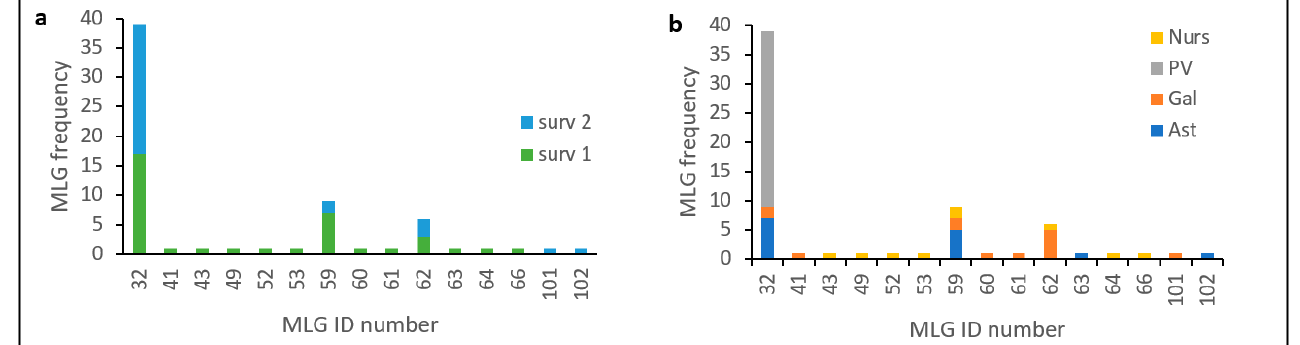
Figure 2. Frequency of MLG identified in the Spanish population of Fusarium circinatum : ( a ) by survey; ( b ) by geographic origin. MLG identification number as in Berbegal et al. [13]. MLG 101 and MLG 102 are new haplotypes detected in 2018–2021. Isolates collected from surveys (Surv) in 2004–2011 (Surv 1) and 2018–2021 (surv 2), from nurseries (Nurs), País Vasco (PV), Galicia (Gal), and Asturias (Ast). Nurseries treated as a population.